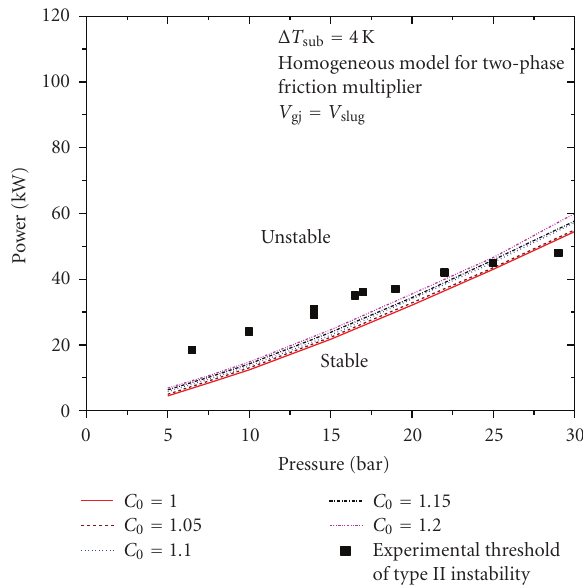
Figure 10: E ff ect of void distribution parameter on threshold of Type I instability observed in HPNCL.